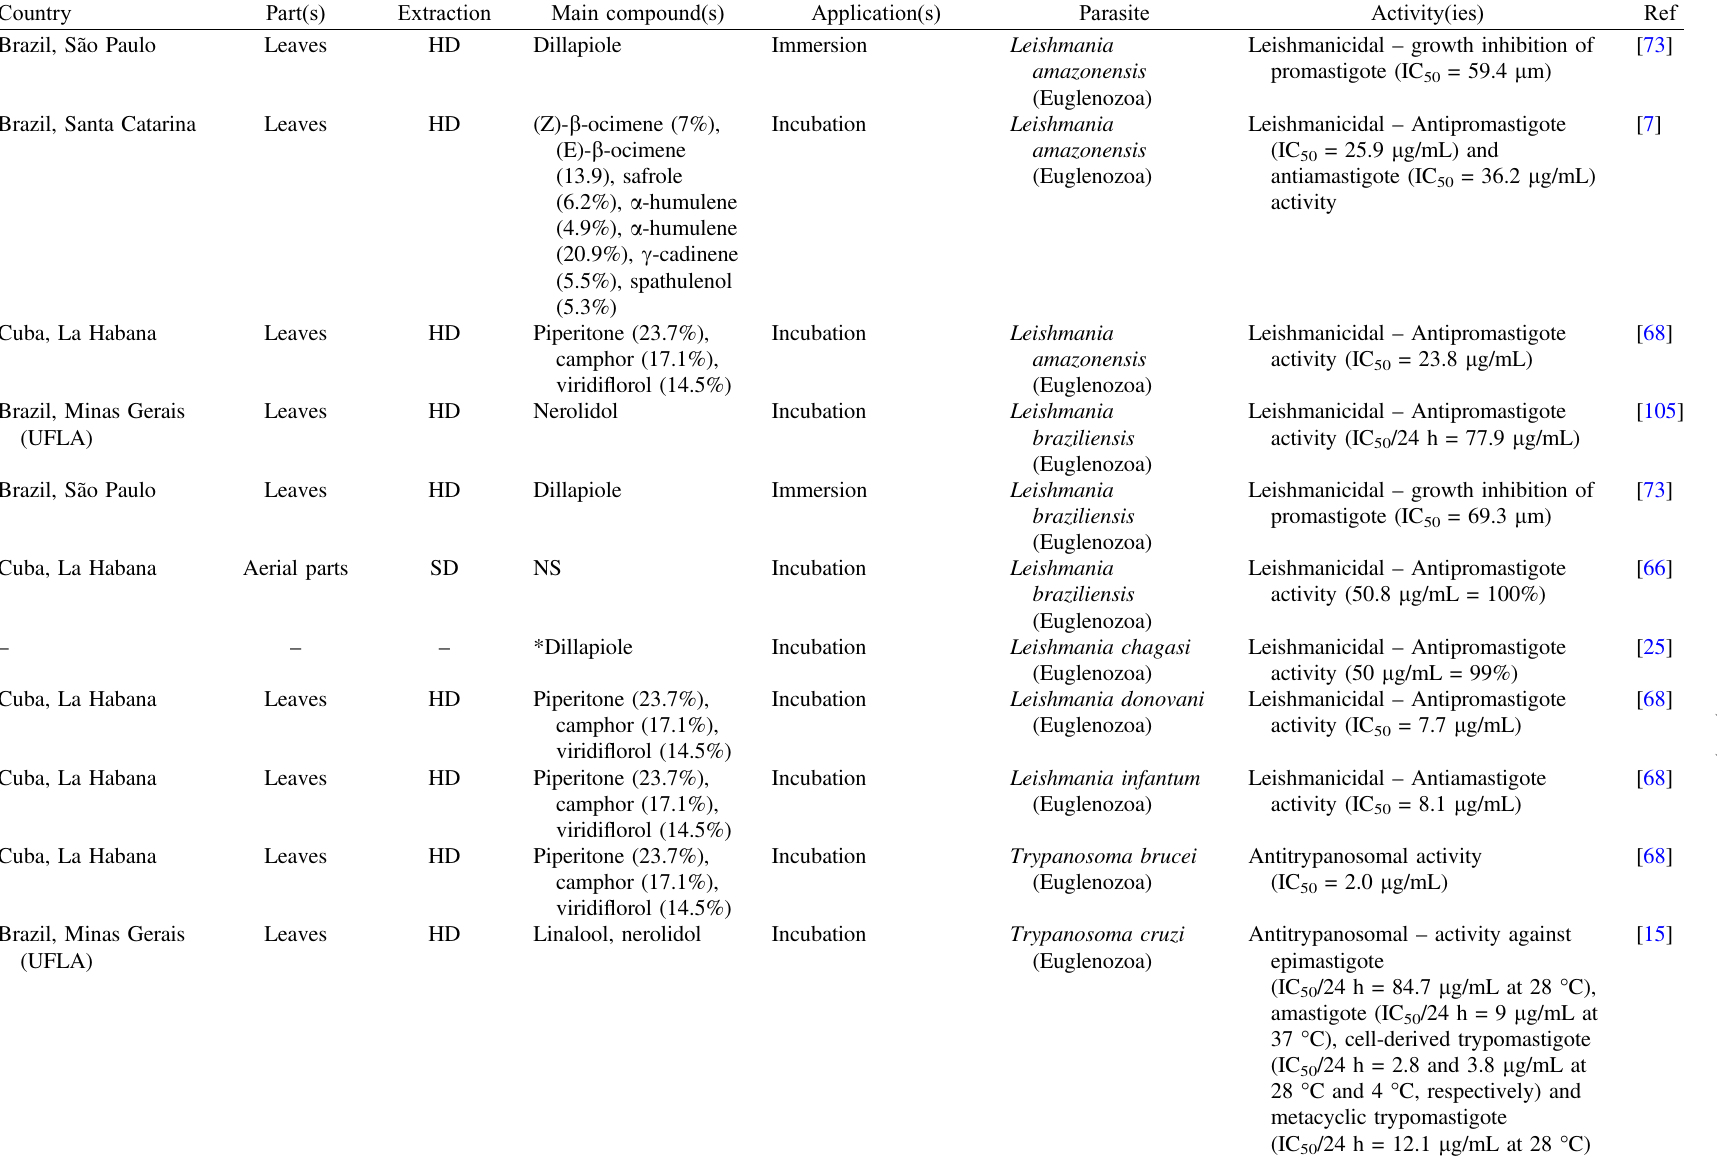
Table 4. Antiparasitic activity.